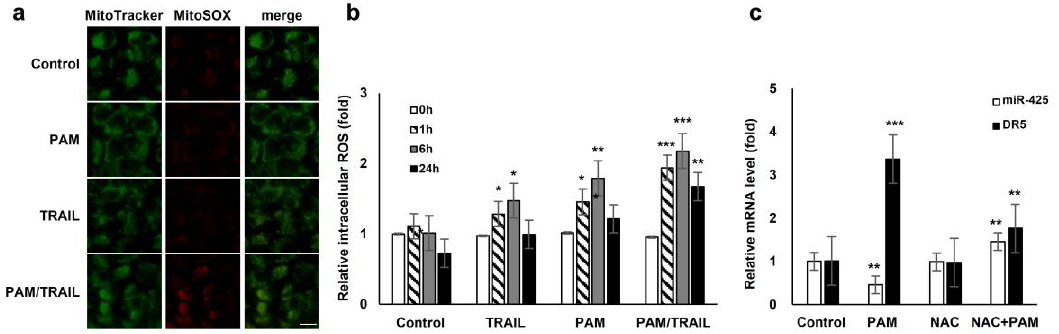
Figure 5. ROS generation is involved in PAM-mediated TRAIL sensitization. ( a ) Reactive oxygen species (ROS) production in mitochondria was induced by treatment with PAM / TRAIL. HeLa cells were treated with PAM, TRAIL, or PAM / TRAIL, after which mitochondrial ROS accumulation was assessed after 24 h by staining the cells with MitoTracker Green and MitoSox Red under a fluorescent microscope. Scale bar: 10 µ m. ( b ) Intracellular ROS generation was induced by treatment with PAM / TRAIL. Cells were treated as in ( a ) for the indicated times. Intracellular ROS were quantified via the H 2 DCF-DA assay. * p < 0.05, ** p < 0.01, *** p < 0.001. ( c ) PAM-induced ROS generation is required for DR5 upregulation and miR-425 downregulation. Pretreatment with a surrogate antioxidant, NAC, reversed PAM-induced DR5, and miR-425 transcriptional modulation. ** p < 0.01, *** p < 0.001.